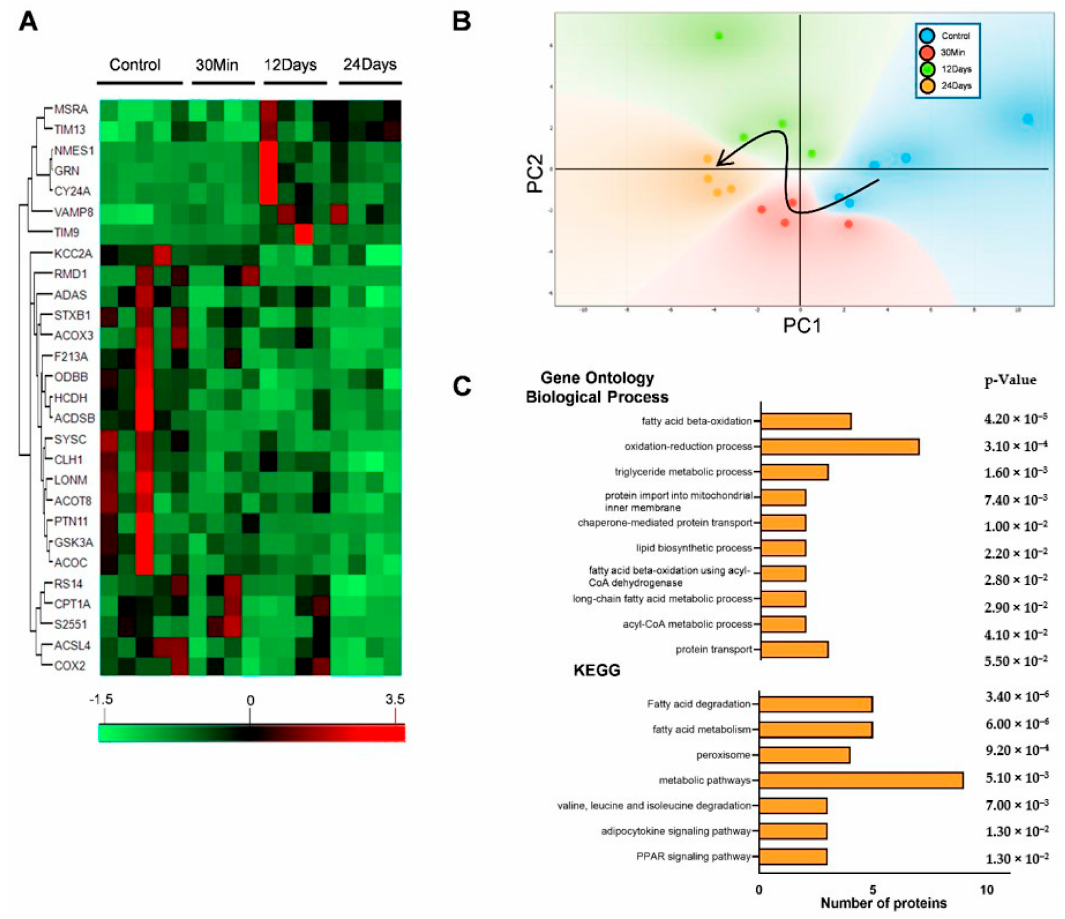
Figure 1. Mitochondrial proteome was significantly altered with complex III inhibition. The quantitative proteomics data were processed using the Perseus software package. ( A ) Unbiased hierarchical clustering of the 28 significantly a ff ected mitochondrial proteins with complex III inhibition. ( B ) Unbiased principal component analysis (PCA) of the 28 significantly a ff ected proteins revealed that theproteinexpressiondi ff